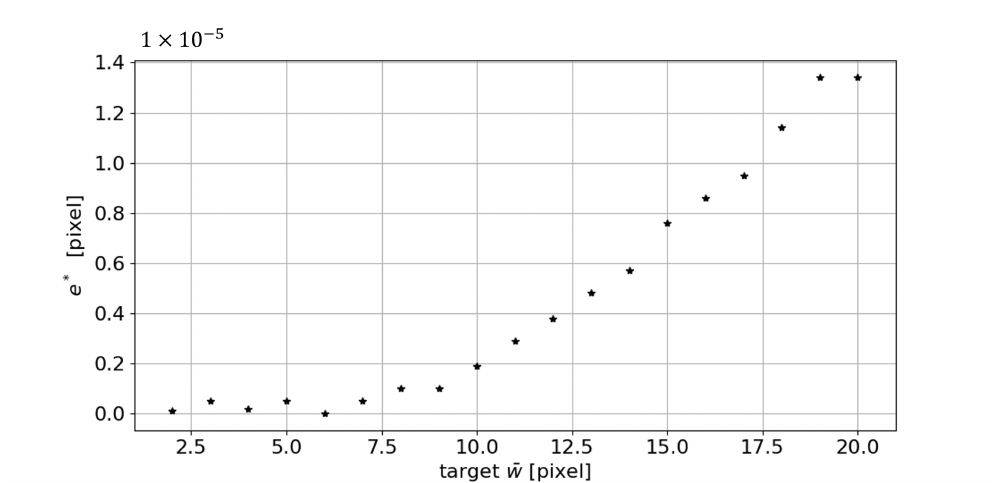
Figure 9. Absolute error e ∗ trend in the measurement of the line mean width as the target ¯ w changes.